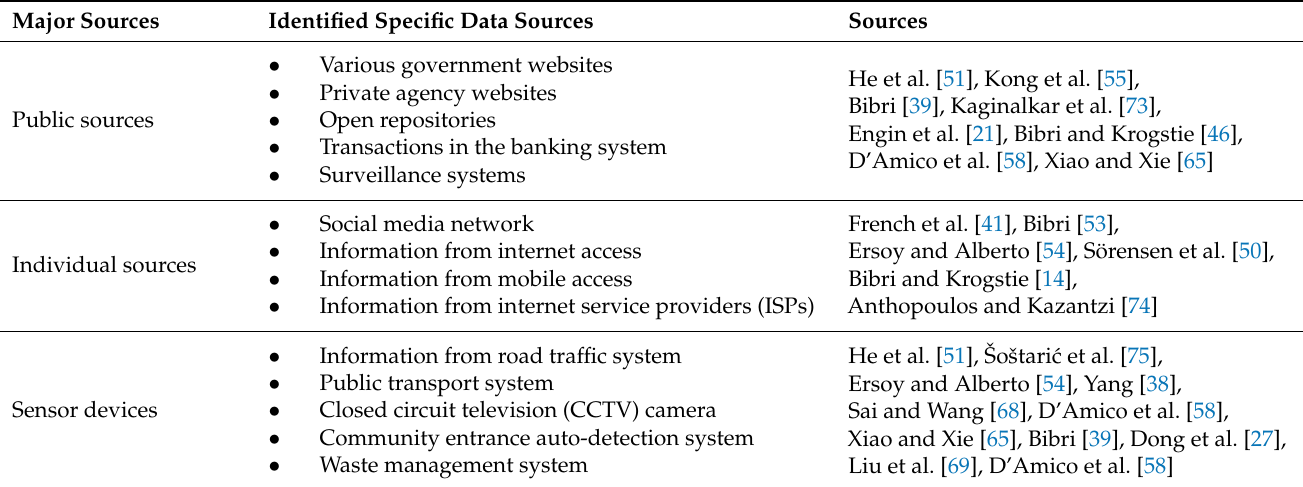
Table 5. Sources of urban big data.